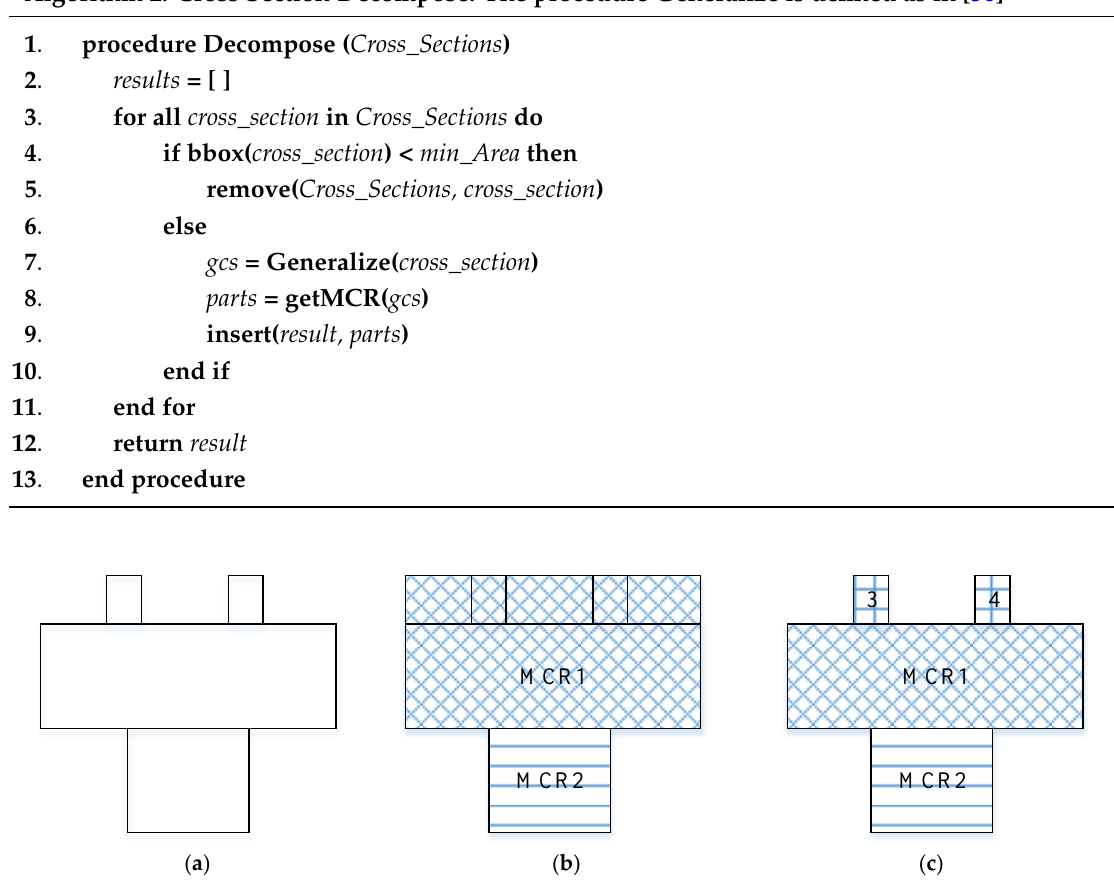
Algorithm 2: Cross Section Decompose. The procedure Generalize is defined as in [36]